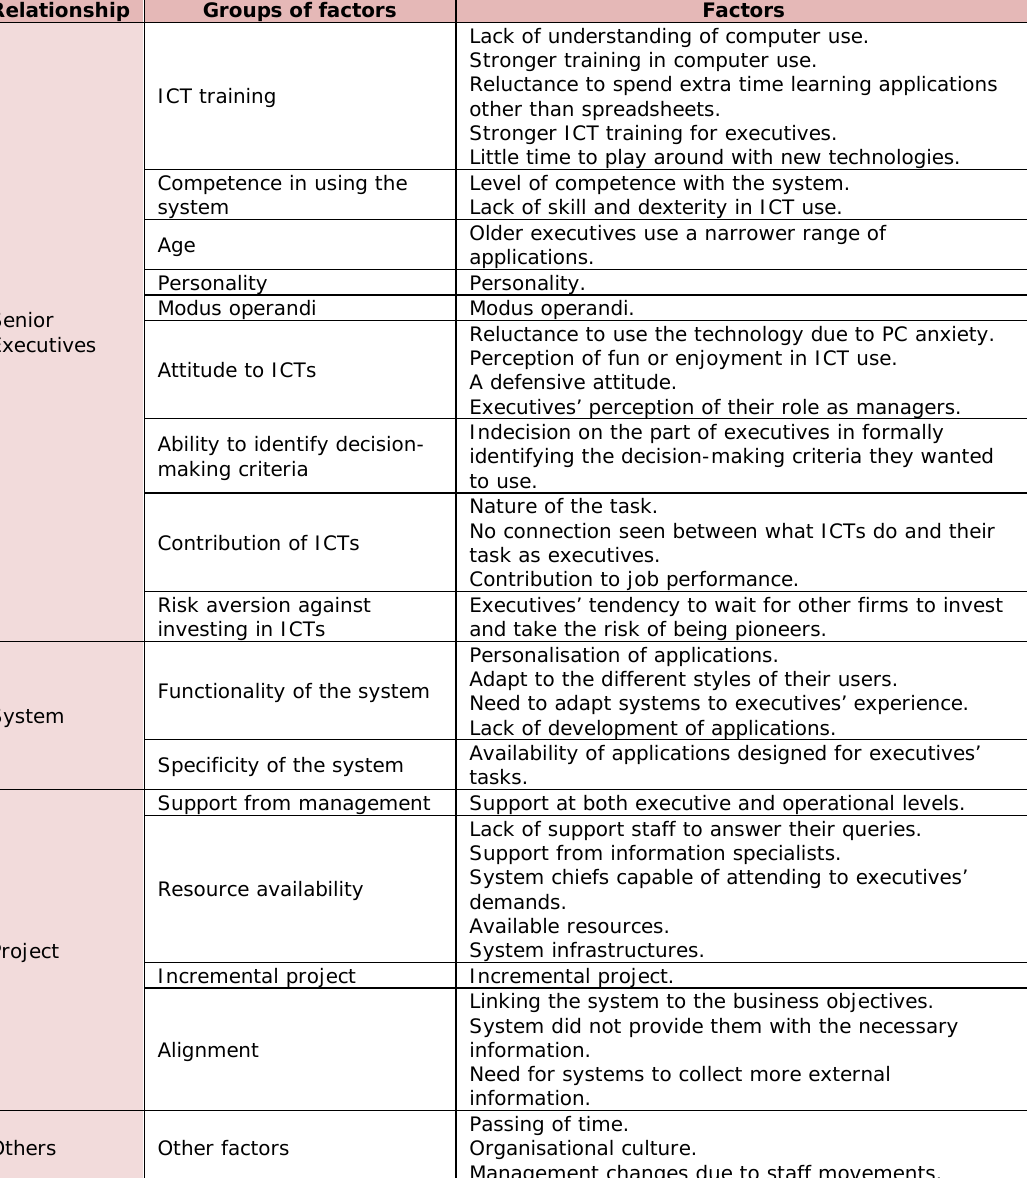
Table 2. “Relationship of factors with: Senior Executives, System, Project and